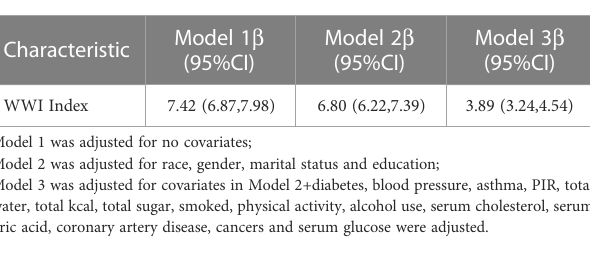
TABLE 5 Analysis between WWI index with onset age of asthma.